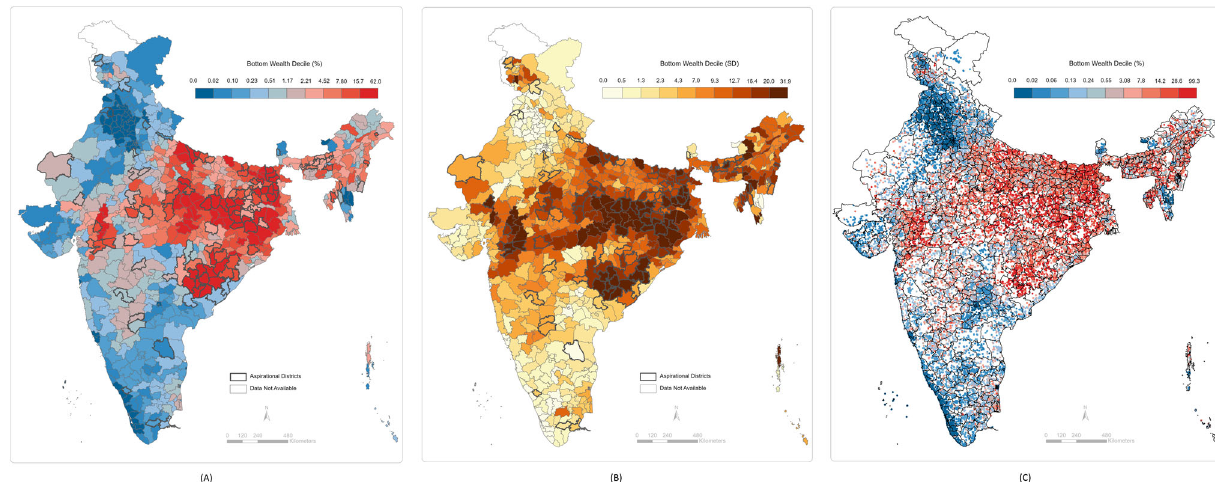
Fig. 5 Small area maps of households in the bottom 10th wealth percentile throughout India. A Geographic prevalence of bottom 10th wealth percentile individuals across 640 districts in India. B District-level distribution of cluster-level inequality for bottom 10th wealth individuals across 640 districts in India. C Geographic prevalence of bottom 10th wealth percentile individuals across 30,170 clusters in India.